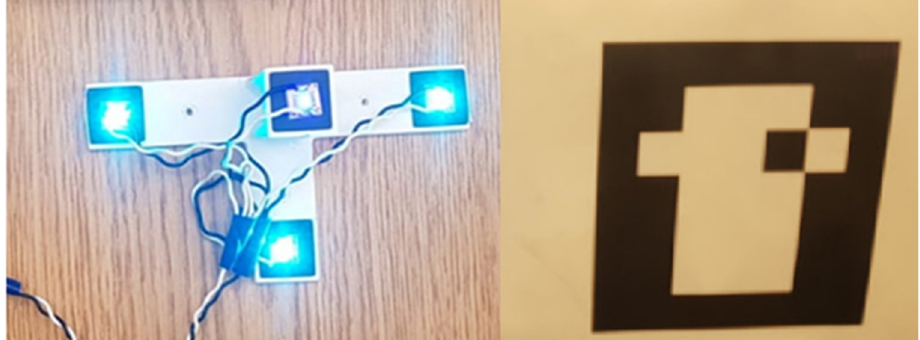
Figure 7. SVGS landing target ( left ), and ArUco landing target ( right ) [20,21].